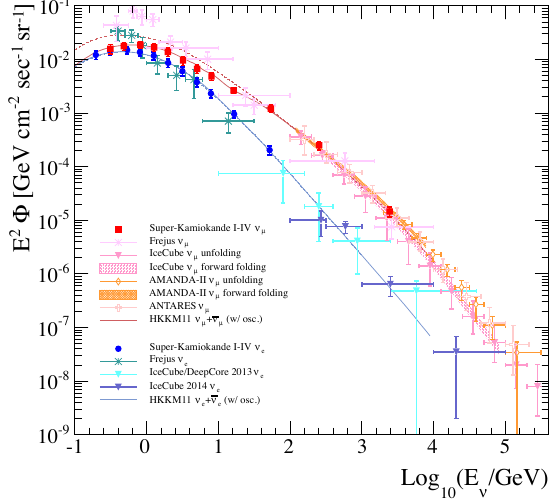
Figure 2. The atmospheric ν e flux results by IceCube shown with the flux predictions. Figure is taken from [2]. Figure 1. The atmospheric muon neutrino flux measured by sev- eral experiments from 100 GeV to several PeV (upper), and the comparison of IceCube measurements and the theoretical pre- dictions of conventional and prompt fluxes (lower). Figures are taken from [1].